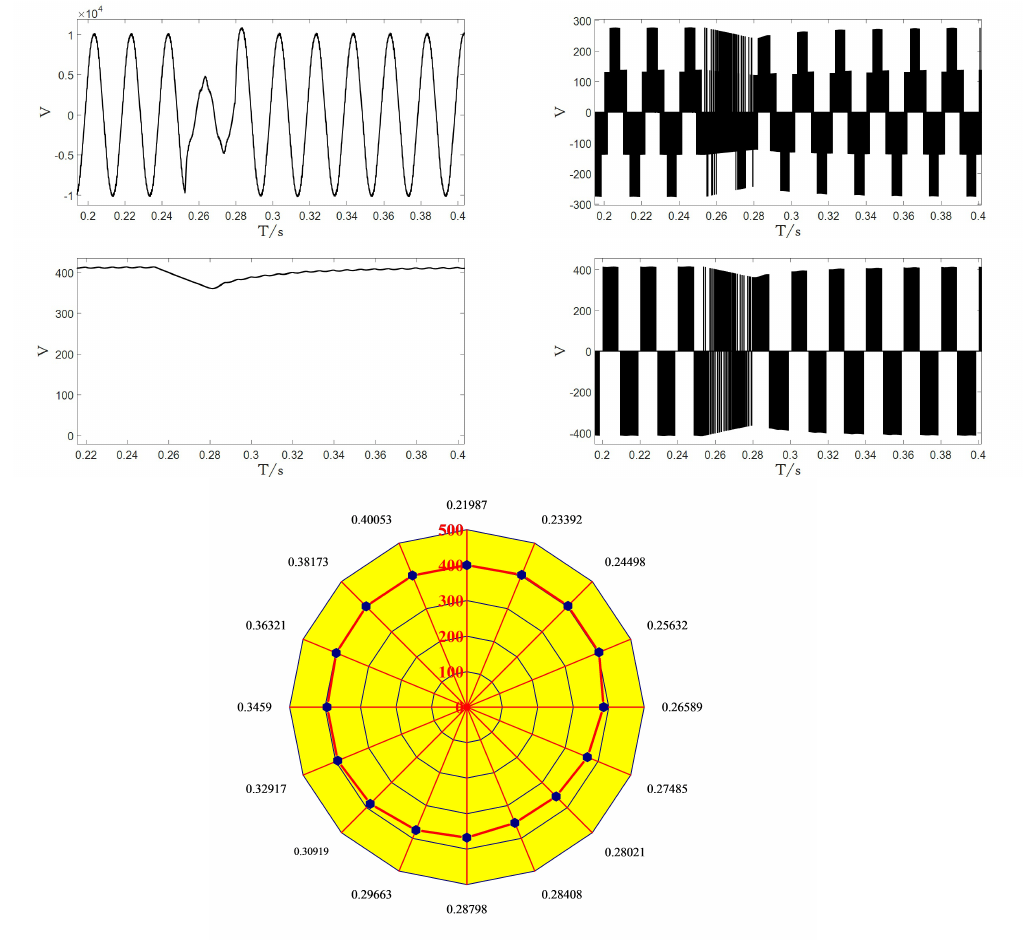
Figure 15. Response of the control system during load changes.